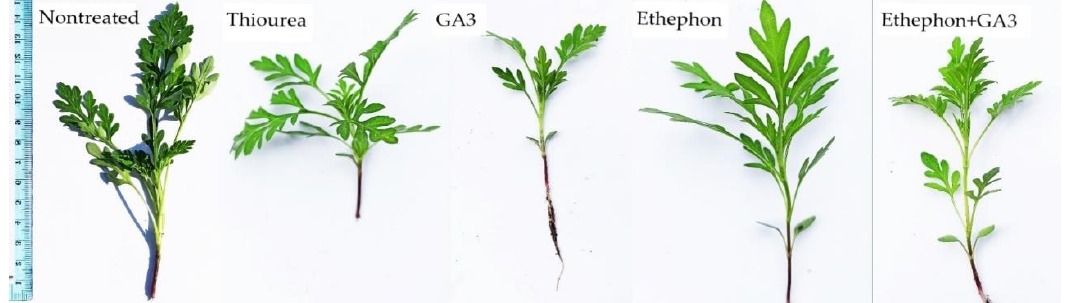
Figure 7. Ambrosia artemisiifolia young plants showing slight deformations upon chemical treatments.